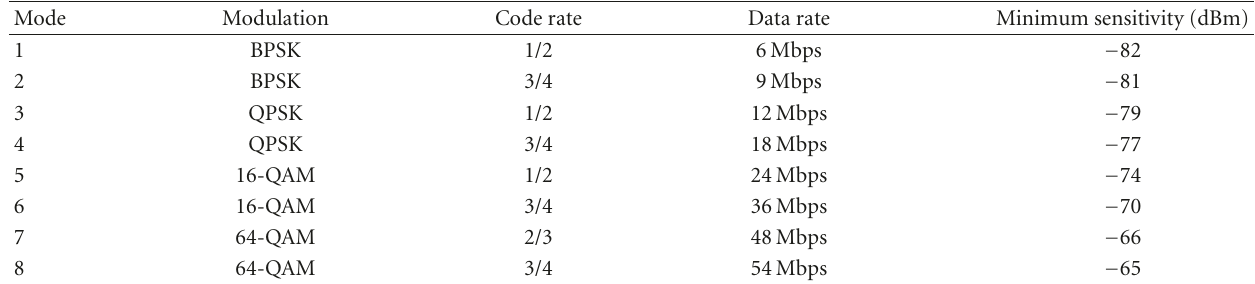
Figure 5: Data rate transition diagram. Table 2: IEEE 802.11a PHY